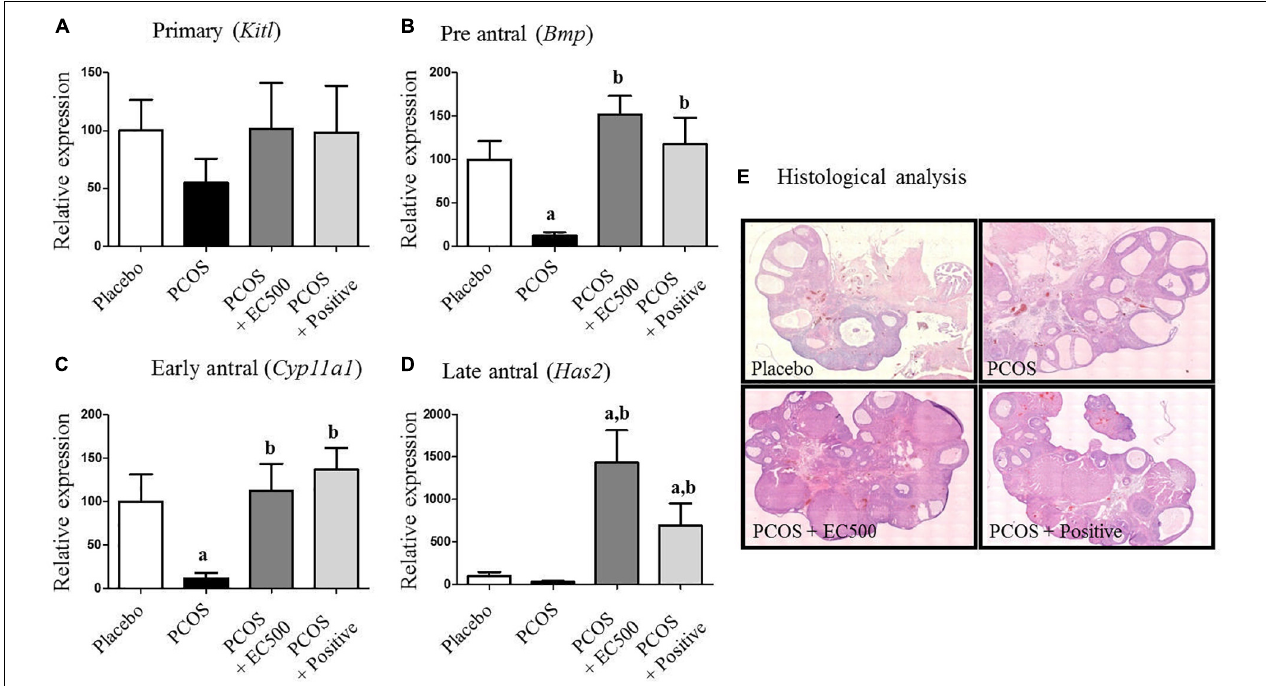
FIGURE 4 | Effects of E. cava on the mRNA expression of folliculogenesis-related genes and sex steroid hormone receptors in the ovaries of rats. For PCOS experiments, 6-week-old female rats were administered letrozole pellets (0.1 mg/kg/day). After 2 weeks, E. cava extract was administered via P.O. treatment every day for 2 weeks. (A) KitL , (B) Bmp , (C) Cyp11a1 , and (D) Has2 mRNA expression was tested using RT-PCR in ovarian tissue from rats of each experimental group. Experiments were carried out in triplicate, and the data are expressed as the means ± SEM ( n = 5–8). a p < 0.05 vs. placebo group, b p < 0.05 vs. PCOS group. (E) Histological analysis of an ovary and its sections stained with H&E. Magnification, 40 × . EC, E. cava extract; PCOS, polycystic ovary syndrome.